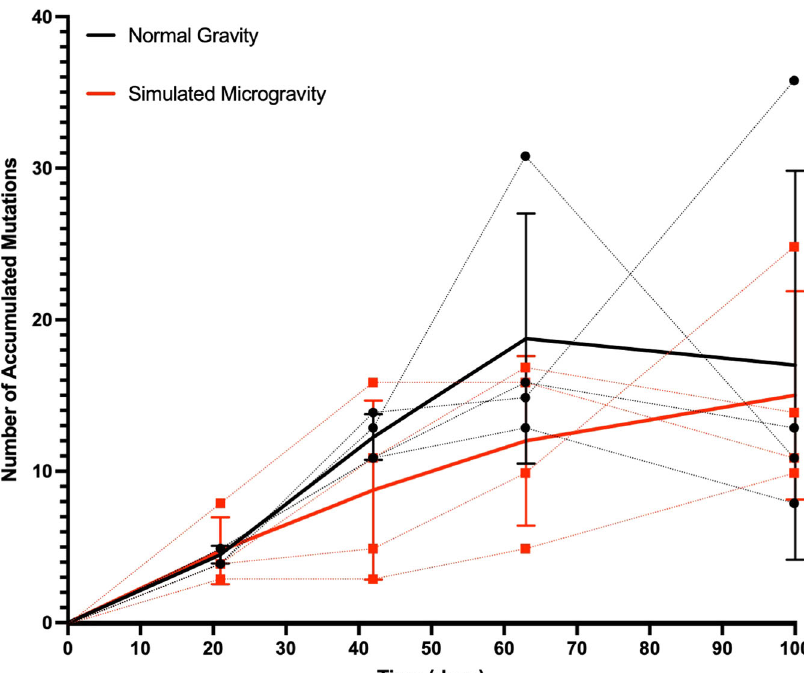
Fig. 4 Populations in simulated microgravity accumulate less mutations. The number of accumulated mutations were plotted for each normal gravity population (blue dotted lines) and each simulated microgravity population (yellow dotted lines) for each sequencing time point. The mean (solid lines) and standard deviation (error bars) were then plotted for each environment. Linear regression determined slopes were signi fi cantly different ( p < 0.0001). Data was plotted and statistical analysis were performed in GraphPad Prism ® 9.2.0. signi fi cance is reported as a two-tailed p-value where * p ≤ 0.05, ** p ≤ 0.01, *** p ≤ 0.001 and **** p ≤